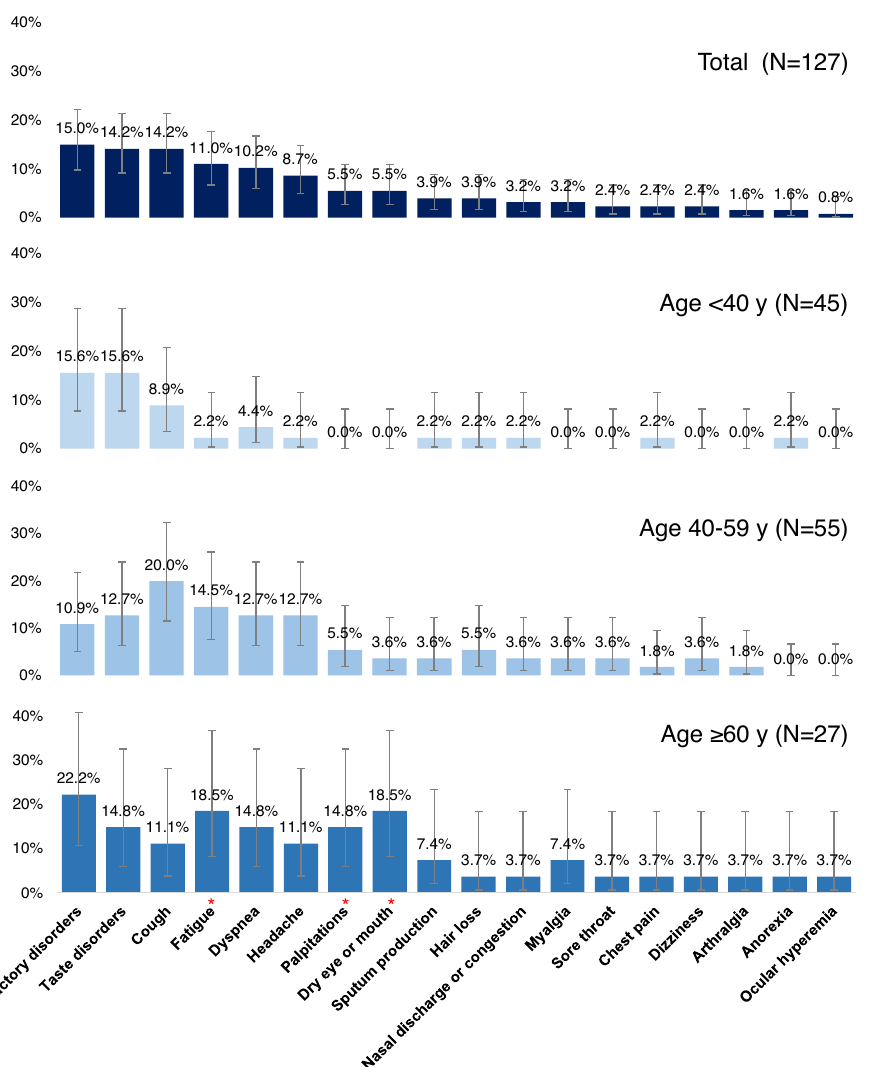
Figure 2. Prevalence of Long COVID symptoms by age. Responses were collected at a median of 29 days [IQR 23–128] after COVID-19 onset. Asterisks (*) indicate statistically significant differences between age groups (p < 0.05, chi-square or Fisher’s exact